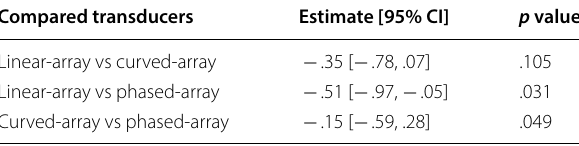
Table 4 Difference in time elapsed until a diagnosis was made between transducer